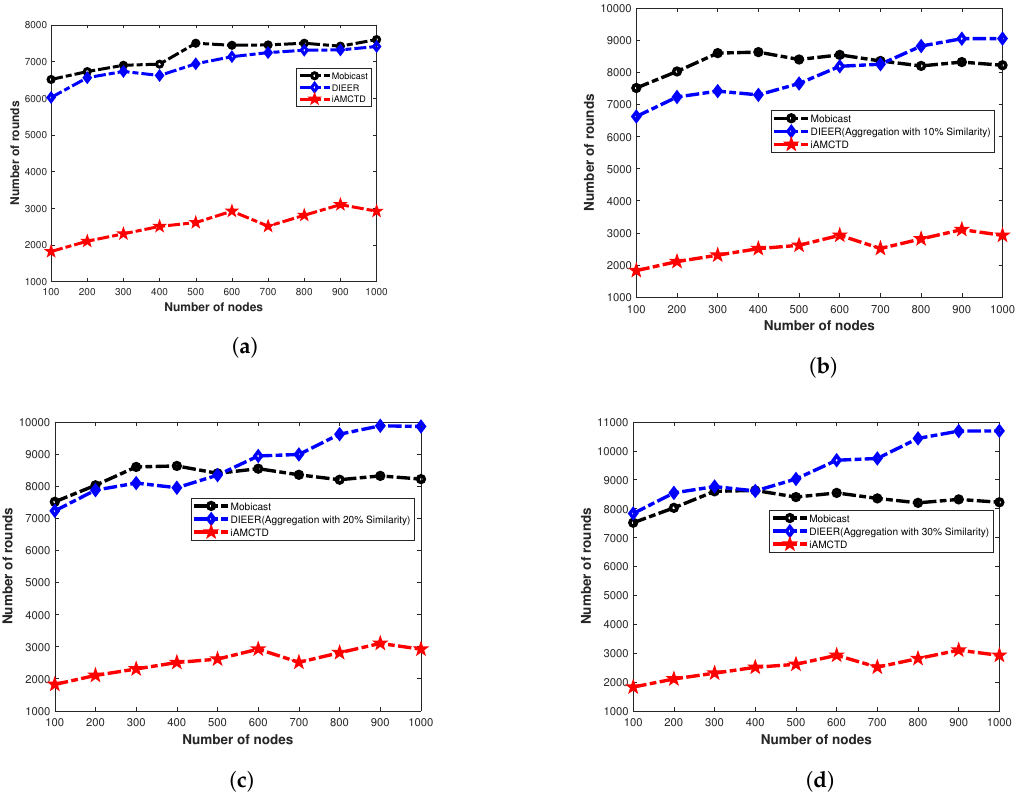
Figure 11. Network lifetime analysis. ( a ) Network lifetime without Aggregation; ( b ) Network lifetime with 10% data duplication; ( c ) Network lifetime with 20% data duplication; ( d ) Network lifetime with 30% data